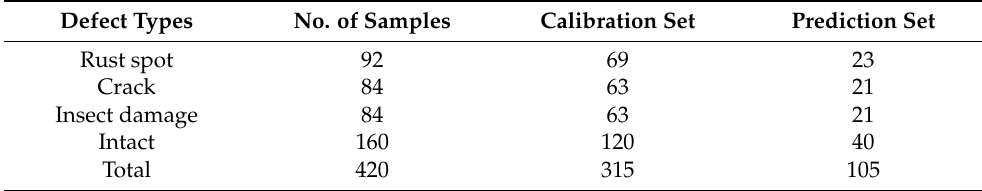
Table 1. The sample set results were divided by the SPXY algorithm. Defect Types